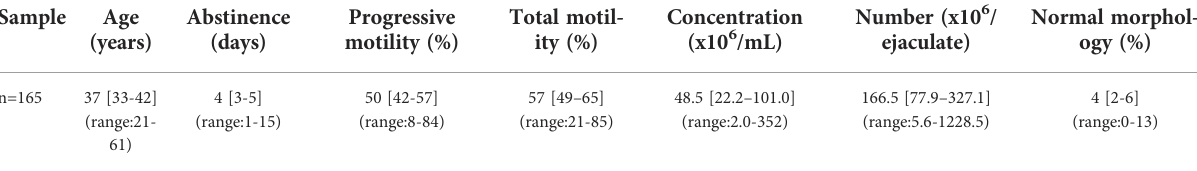
TABLE 1 Median, [IQR] and (range) of semen parameters are reported in subjects (n=165) where CellROX ® Orange and DHE were detected.